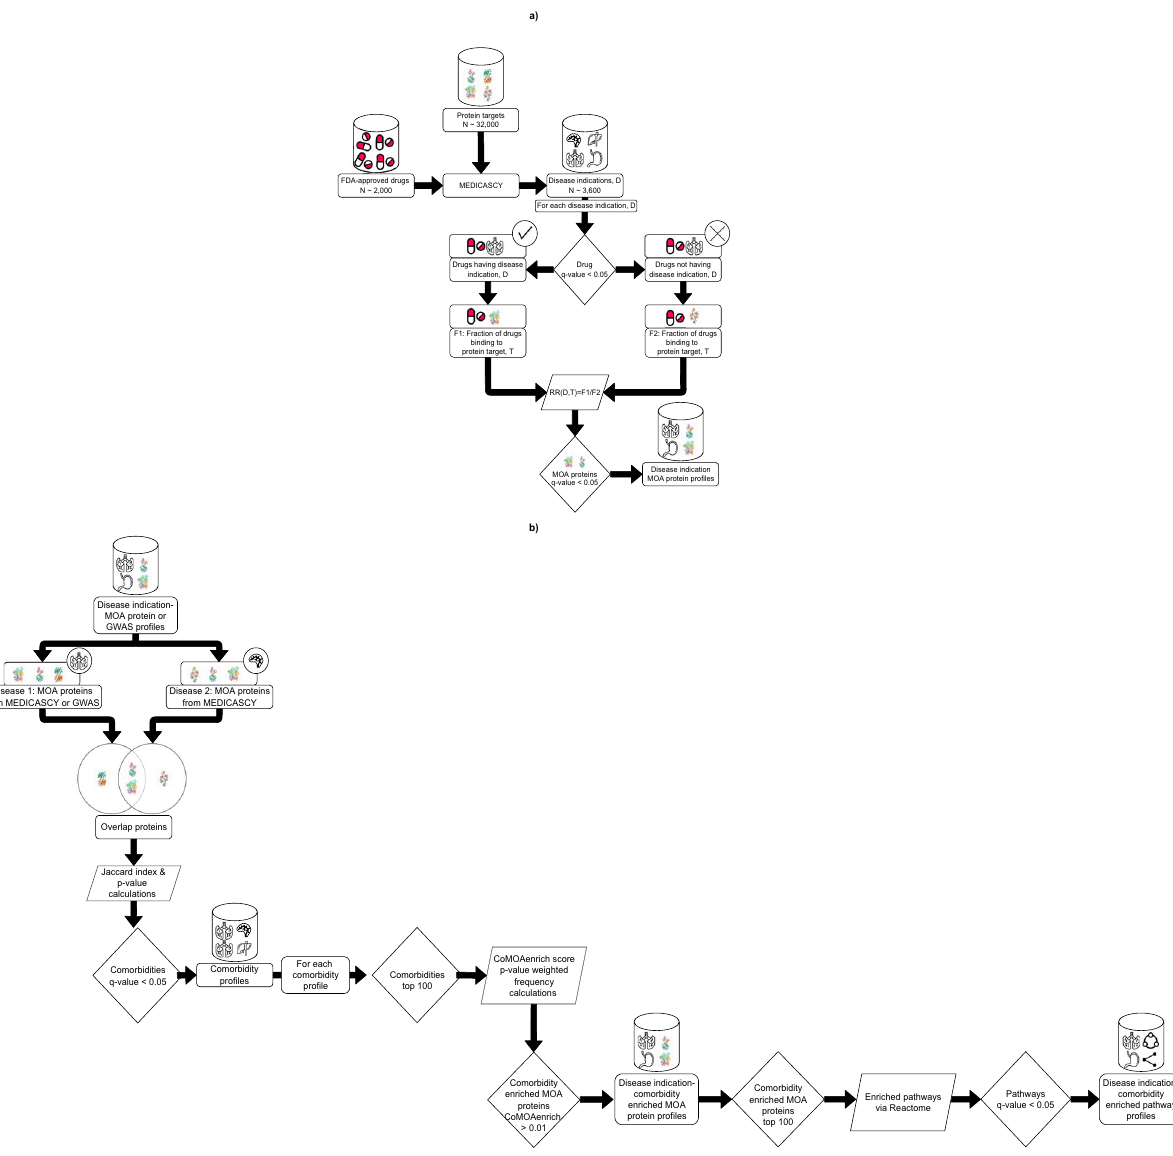
Disease 2: MOA proteins from MEDICASCY